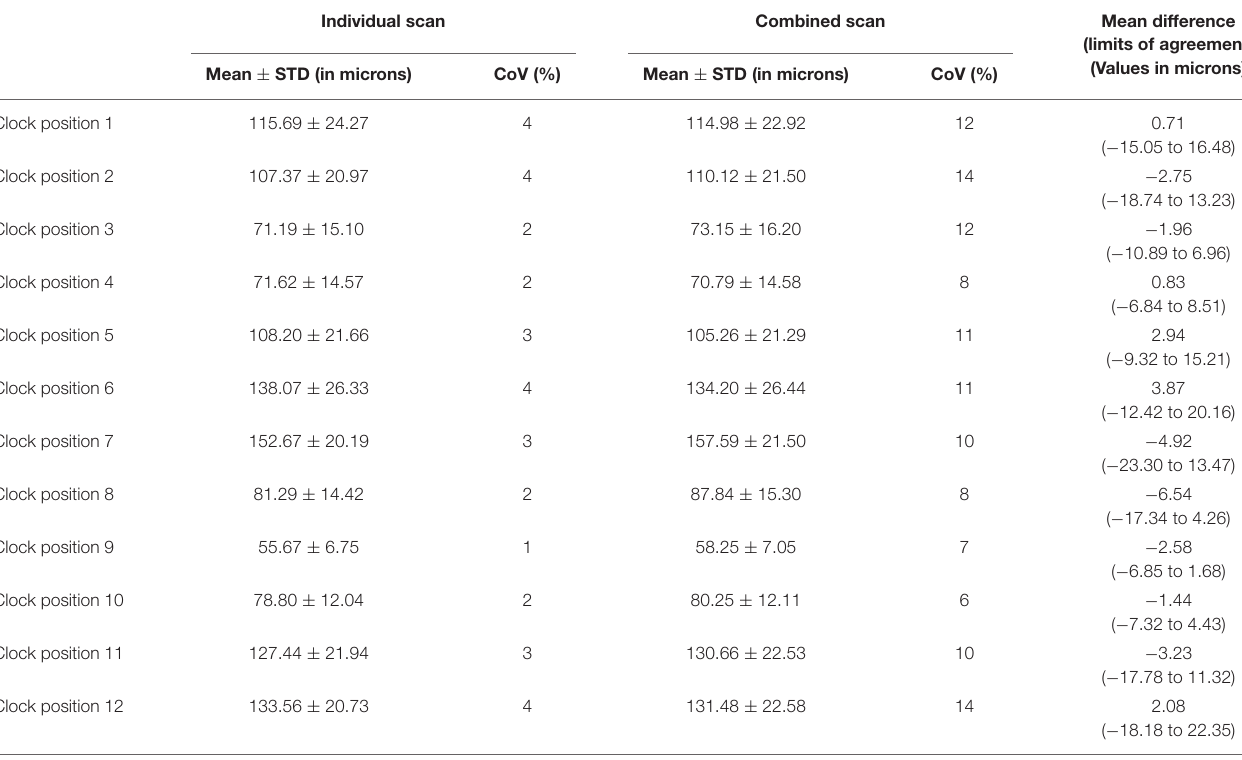
TABLE 4 | Peripapillary nerve fiber layer thickness for 12 clock sector position with two scan modes, and the coefficient of variation (CoV), and the agreement results. Individual scan